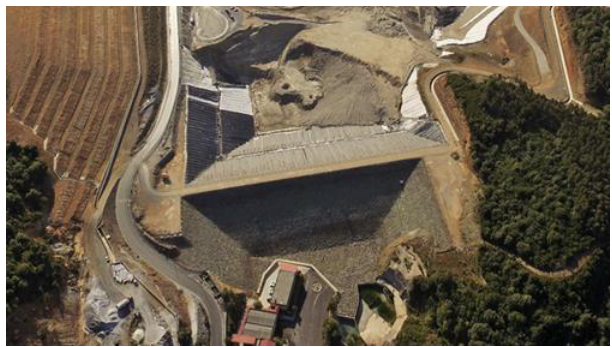
Figure 7. Upstream embankment construction.